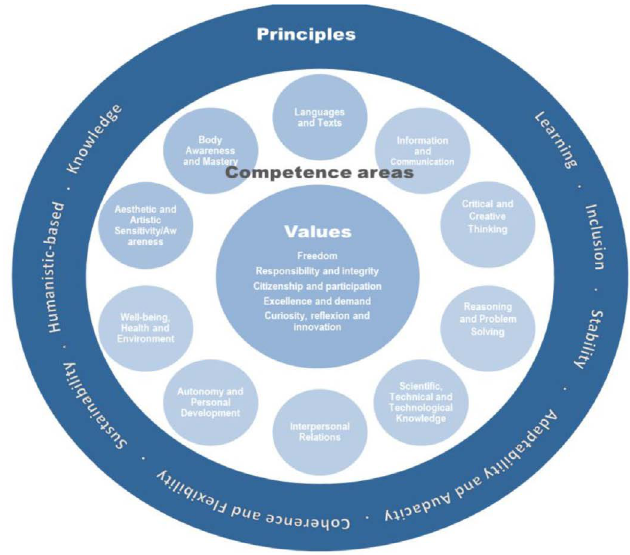
Figure 2: Conceptual Framework for the Students’ Profile by the End of Compulsory Schooling . Source: The Students’ Profile by the End of Compulsory Schooling (Direção-Geral da Educação, 2017, p.